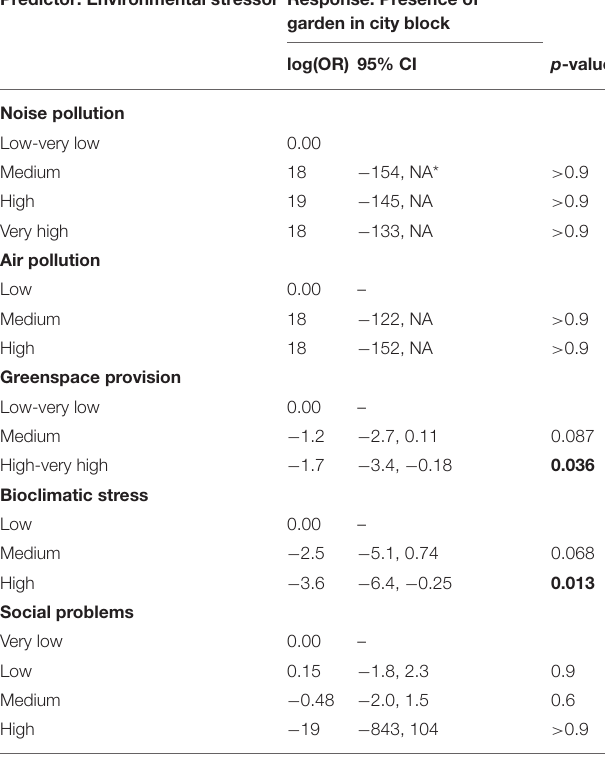
TABLE 5 | Logistic regression summary, investigation correlations of the presence of a garden in a city block and environmental stressors. Predictor: Environmental stressor Response: Presence of garden in city block log(OR) 95% CI p